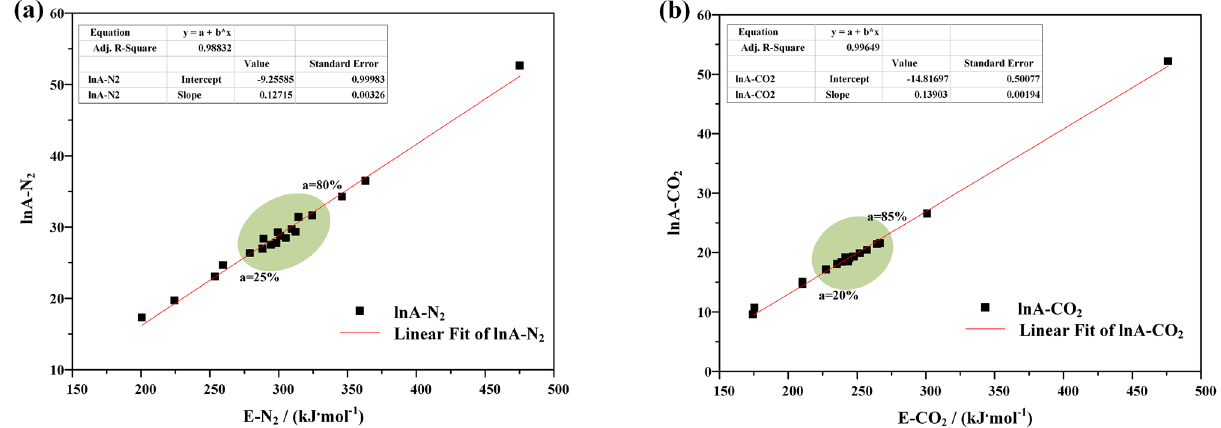
Figure 15. Kinetic compensation effect of oil shale pyrolysis under ( a ) N 2 and ( b ) CO 2